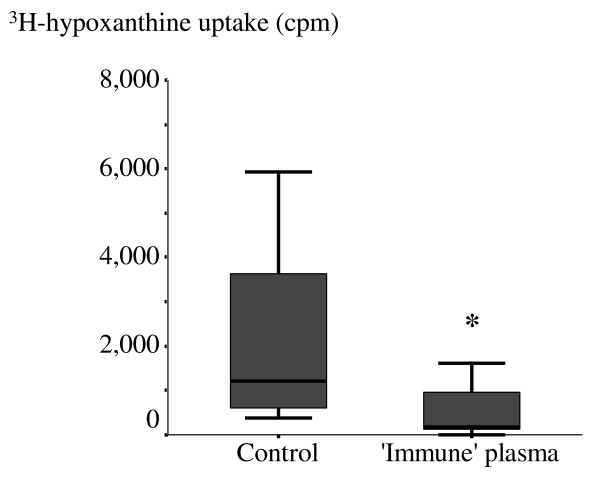
Plasma from acute malaria inhibits 3H-hypoxanthine uptake by Plasmodium falciparum. Parasites were incubated in malaria culture medium with 10% (v/v) 'immune' plasma containing anti-malarial antibodies for 48 hours. Parasite uptake of hypoxanthine (in counts per minute; cpm) is shown as the median values with 25th and 75th percentiles and ranges from 4 experiments in duplicate. Control parasites were incubated in culture medium with 10% plasma from healthy donors. * p ≤ 0.05 (Mann-Whitney U test).